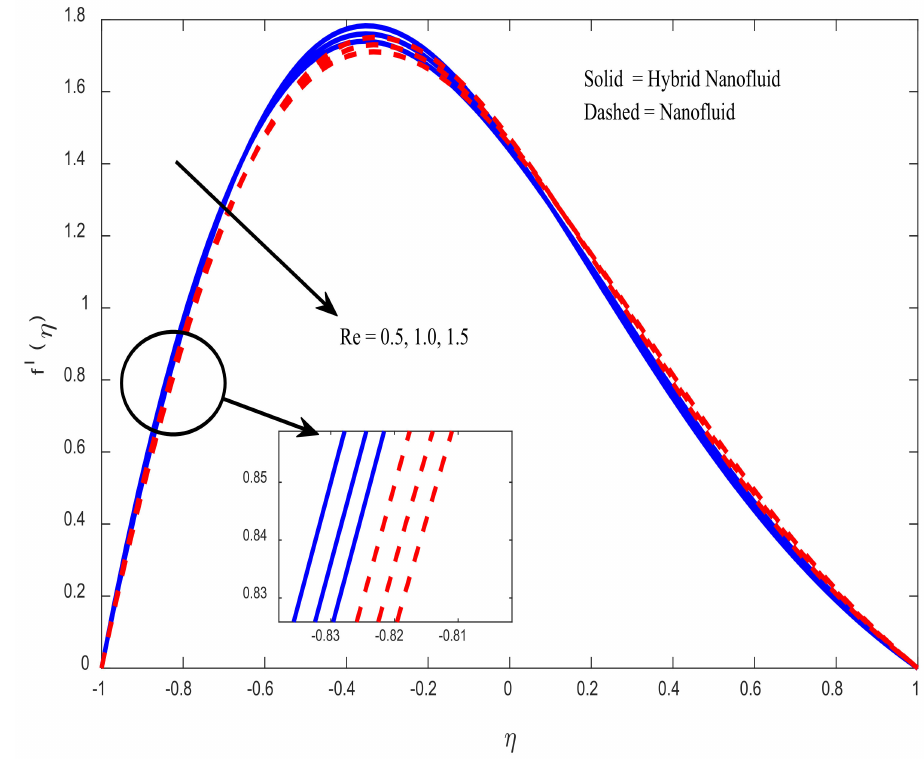
Figure 3. Influence of Re on the velocity profile.